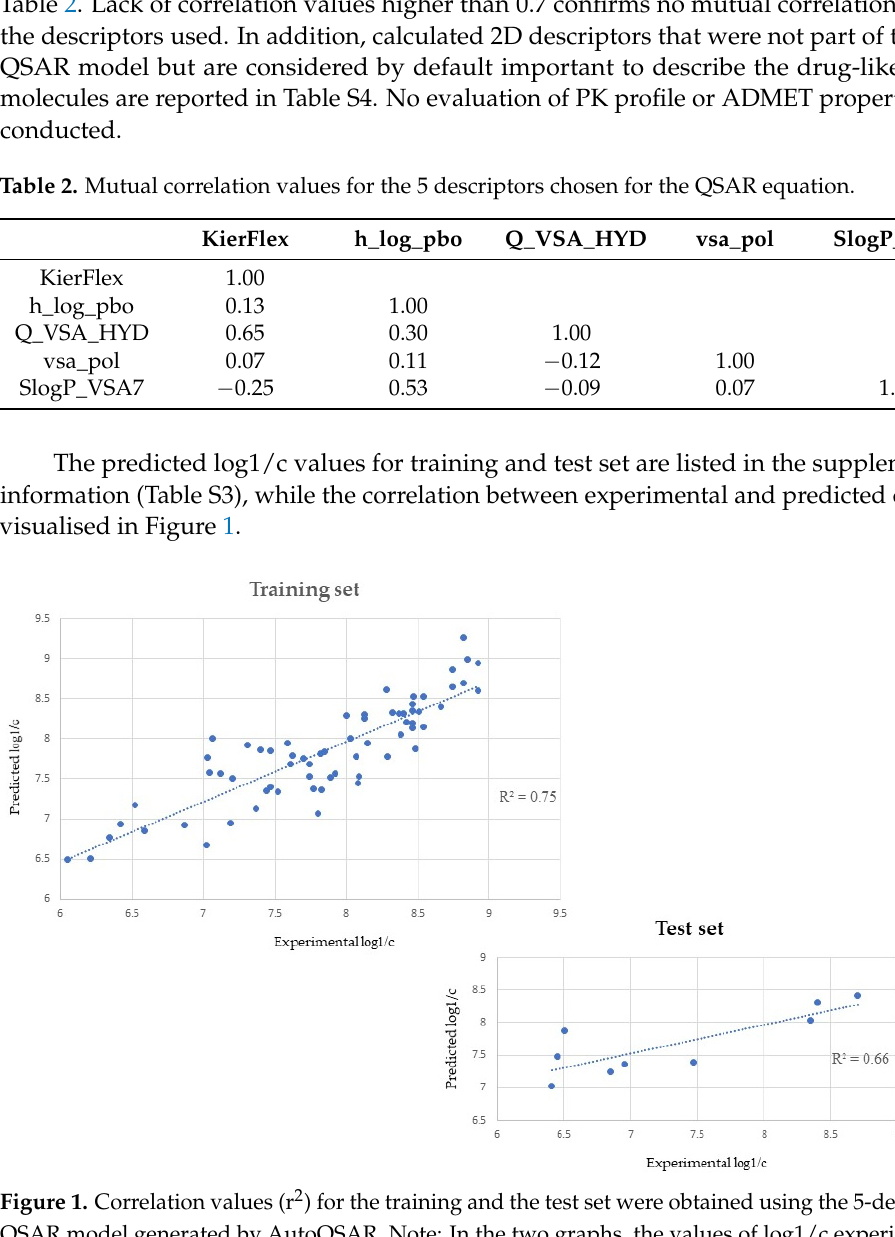
Table 1. Specification of the five descriptors included in the final QSAR model.